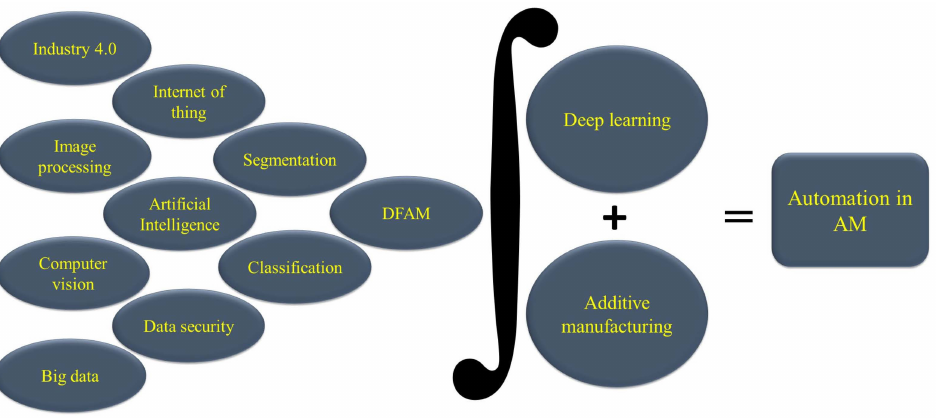
Figure 5. Integration of additive manufacturing with deep